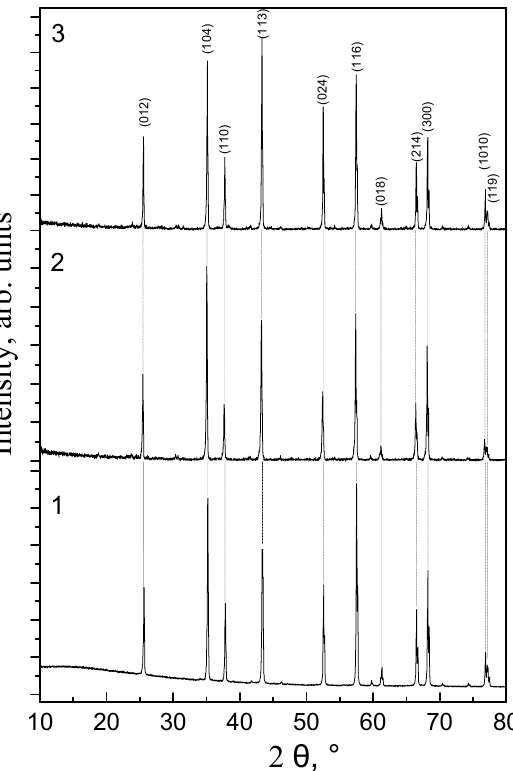
Figure 7. XRD pattern of pristine α -Al 2 O 3 ceramic (1), α -Al 2 O 3 ceramic modified with AlOOH (2) and AlOOH/Ag (3) nanostructures.